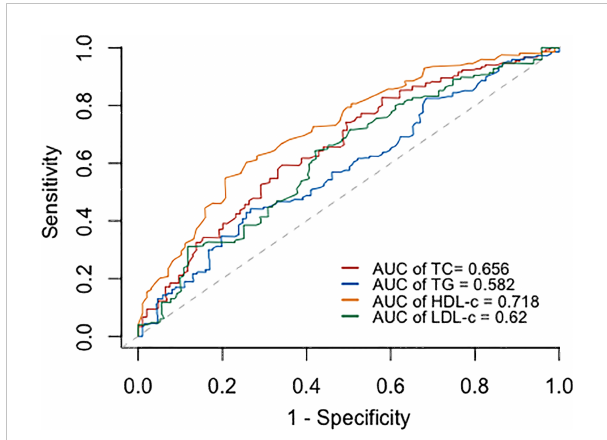
FIGURE 2 Receiver operating curve (ROC) for determining the optimal cut- off value of TC, TG, HDL-c, and LDL-c.